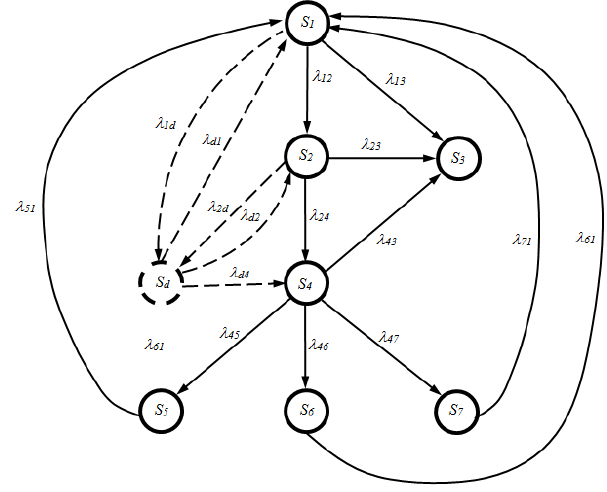
Figure 1. Markovian graph for the torpedo ladle car operation.